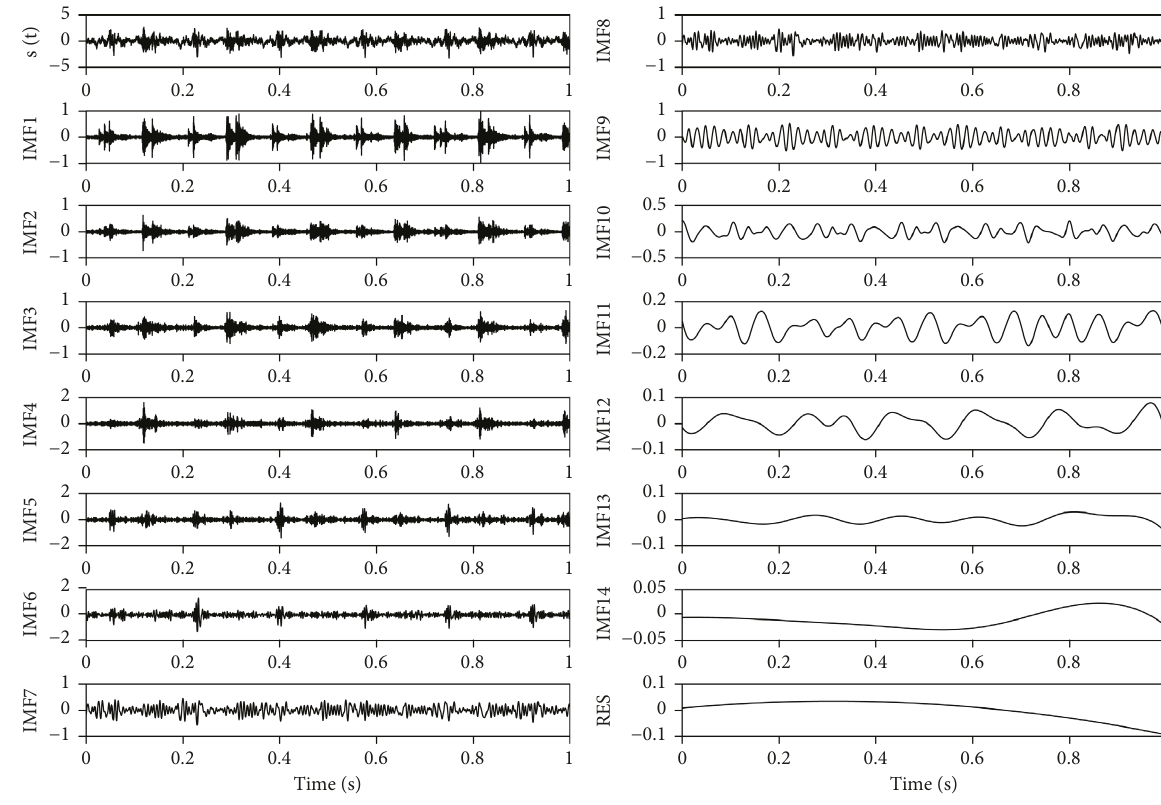
Figure 12: The result of EEMD decomposition. Table 1: Calculation results of all IMF